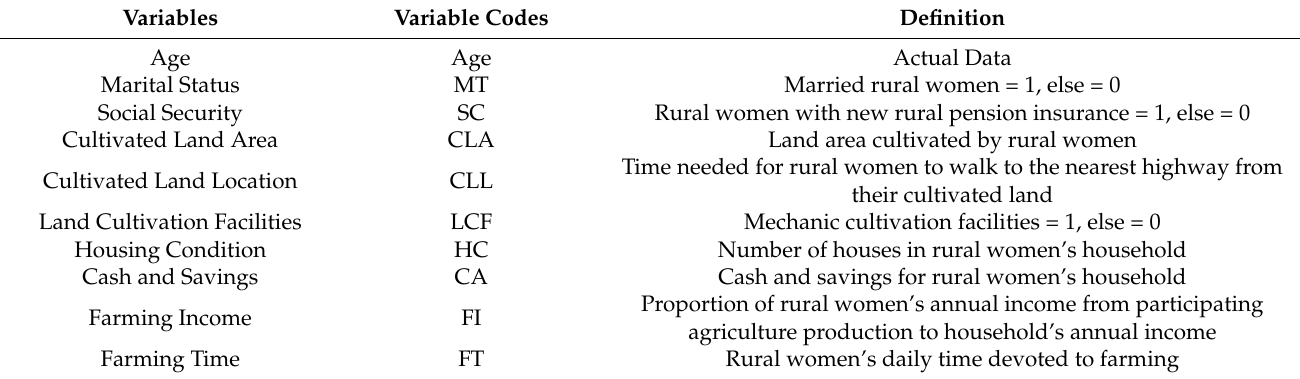
Table 2. Definition Table of Control Variables and Remaining Independent